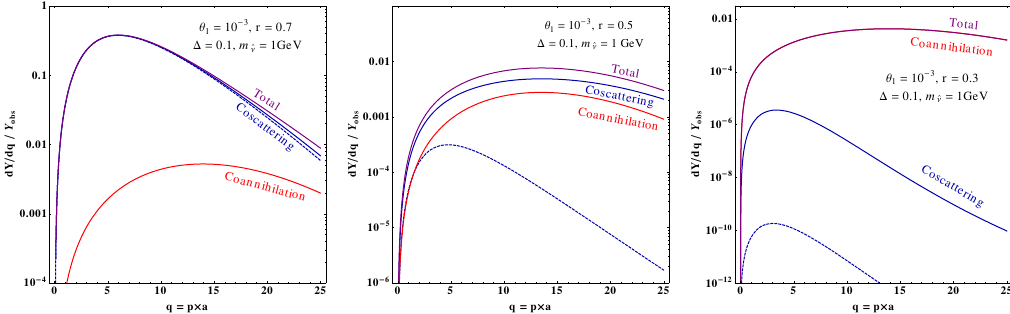
Figure 3 . Benchmark results for relic density calculation in the coscattering (left), mixed (central), and coannihilation (right) phases. The red curves are the contributions from the (cid:12)rst term of eq. (4.13) which corresponds to a pure coannihilation calculation. The blue solid curves are due to the coscattering contributions from the second term of eq. (4.13). The purple curves are the total contributions. We can see that in the coscattering phase and the coannihilation phase the total contribution is dominated by one term, while in the mixed phase both terms give comparable contributions. The blue dashed curves are calculated from the coscattering formula of eq. (4.4). Only in the coscattering phase the blue dashed curve approximates the correct result.